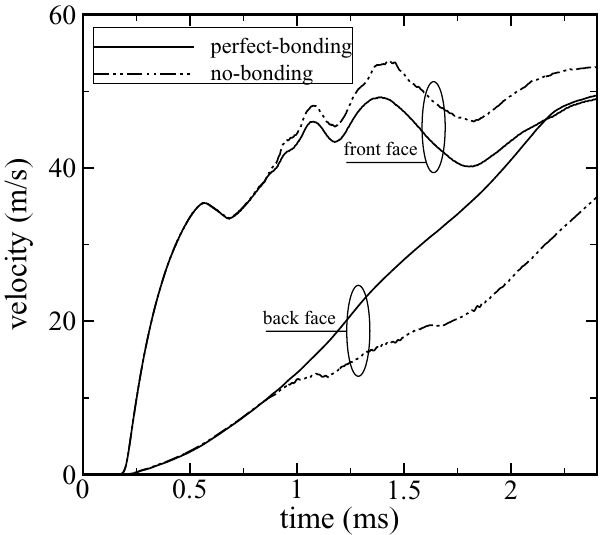
Fig. 8. Comparison of the mid-span displacement history between the perfect- and no-bonding sandwich plates with clamped ends.